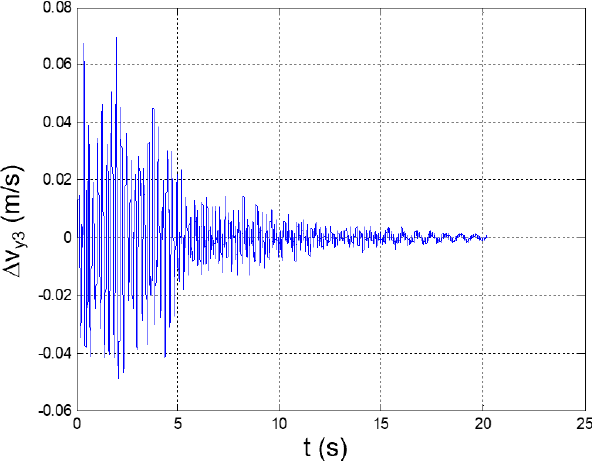
Figure 16. Seismic response, interstory speed at the 2nd floor ( Δ 𝑣 y2 = 𝑣 y2 − 𝑣 y1 ).